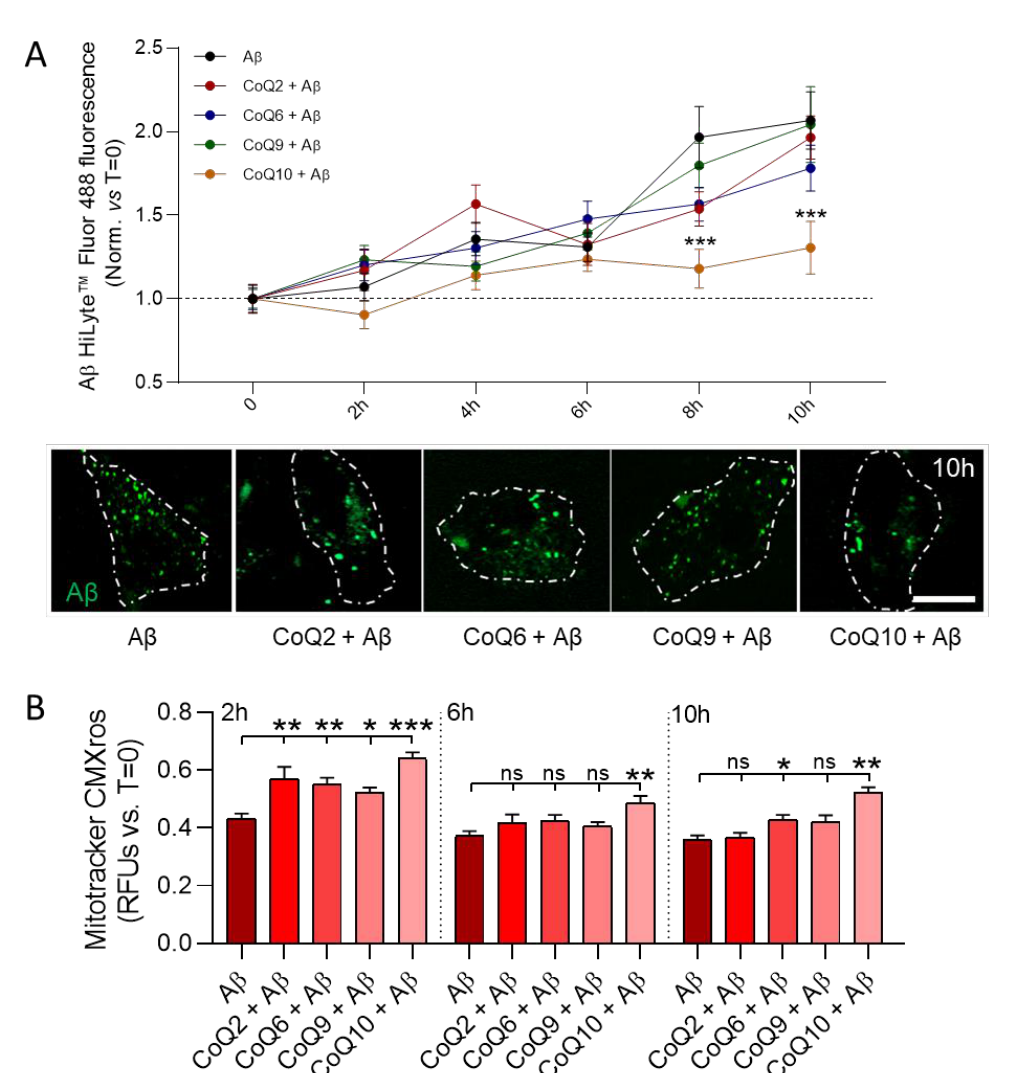
Figure 5. Real-time characterization of A β 25–35 internalization and mitochondrial dynamics. bEnd.3 cells were pretreated with CoQ2, CoQ6, CoQ9, or CoQ10 for 24 h and were then treated with A β 25–35 HyLite TM 488. ( A ) Levels of fluorescent A β 25–35 were measured every two hours and normalized vs. 0 h of exposure. Images show internalized A β 25–35 after 10 h of exposure in individual cells (white line represents the cell outline) (scale bar = 20 µ M). ( B ) Mitochondrial status was quantified as the intensity of Mitotracker CMXRos compared to 0 h of exposure to A β 25–35 . Data are presented as the mean ± SEM. Dunnett’s multiple comparison test compared each A β 25–35 plus ubiquinone treatment with A β 25–35 . ns: not significant, * p < 0.05, ** p < 0.01, *** p < 0.001, (>30 cells/condition).